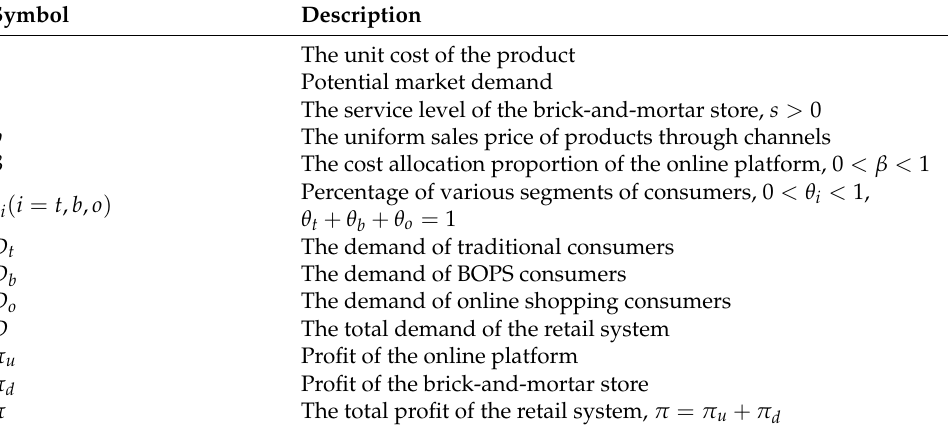
Table 1. The symbolic